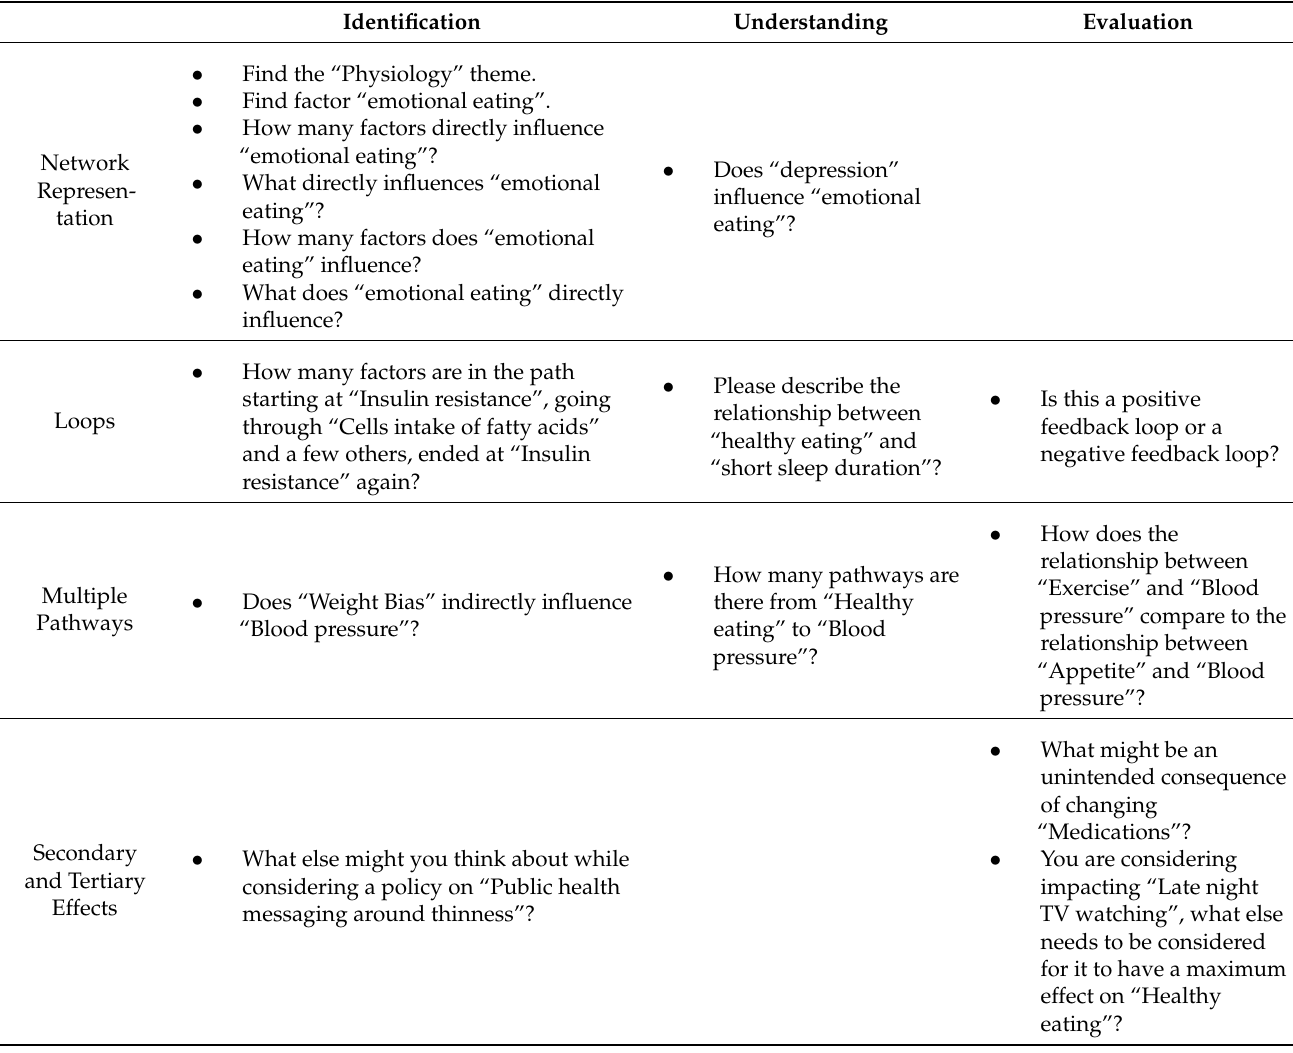
Table 2. Matrix of questions by level of mastery (using Bloom’s taxonomy) and systems thinking aspect.